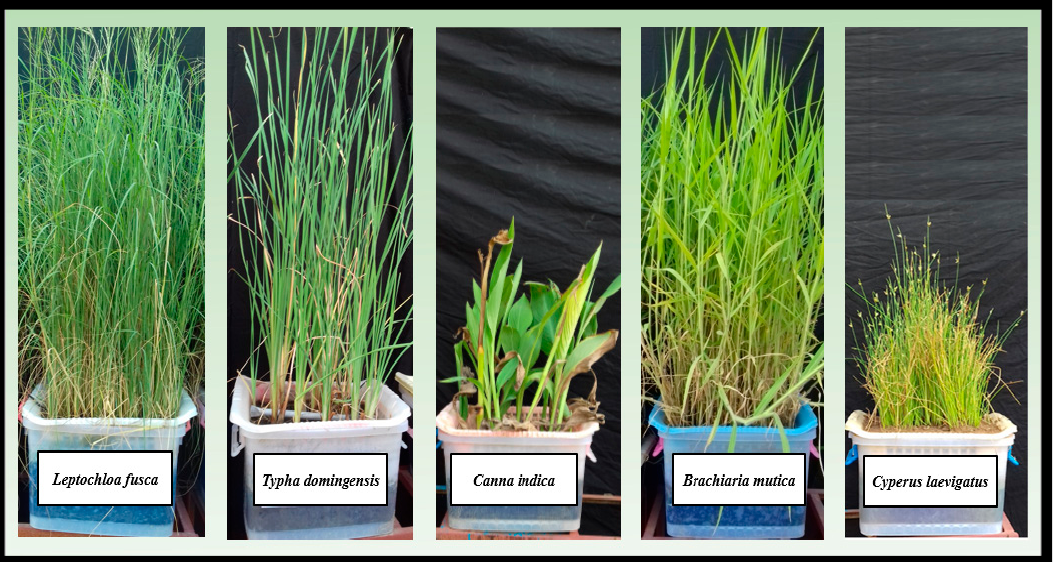
Figure 2. Constructed wetland phytoreactors vegetated with different macrophytic plants for the treatment of tannery effluent.